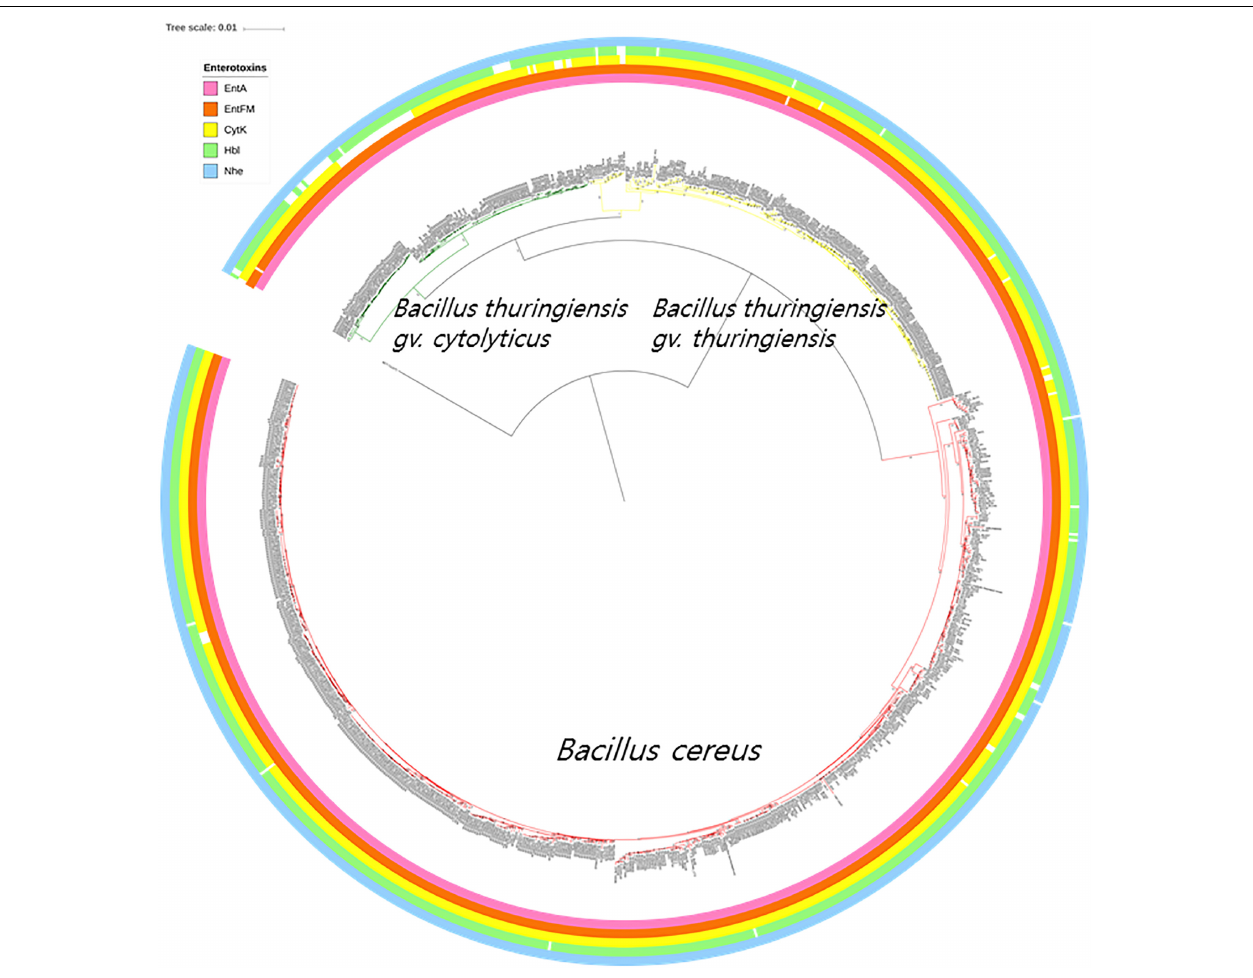
FIGURE 3 | The bacterial core gene-based phylogenomic tree of Bacillus cereus and Bacillus thuringiensis strains together with labeled enterotoxin genes. The numbers at each branching point are bootstrap values. Bar indicates the nucleotide substitution rate per site. Bacillus toyonensis BCT-7112 T was used as the outgroup. Taxonomic groups are indicated in different colors: red, B. cereus ; yellow, B. thuringiensis gv. thuringiensis ; and green, B. thuringiensis gv. cytolyticus . Genes are displayed on the outer circles: EntA, enterotoxin A; EntFM, enterotoxin FM; CytK, cytotoxin K; Hbl, hemolysin BL; Nhe, non-hemolytic